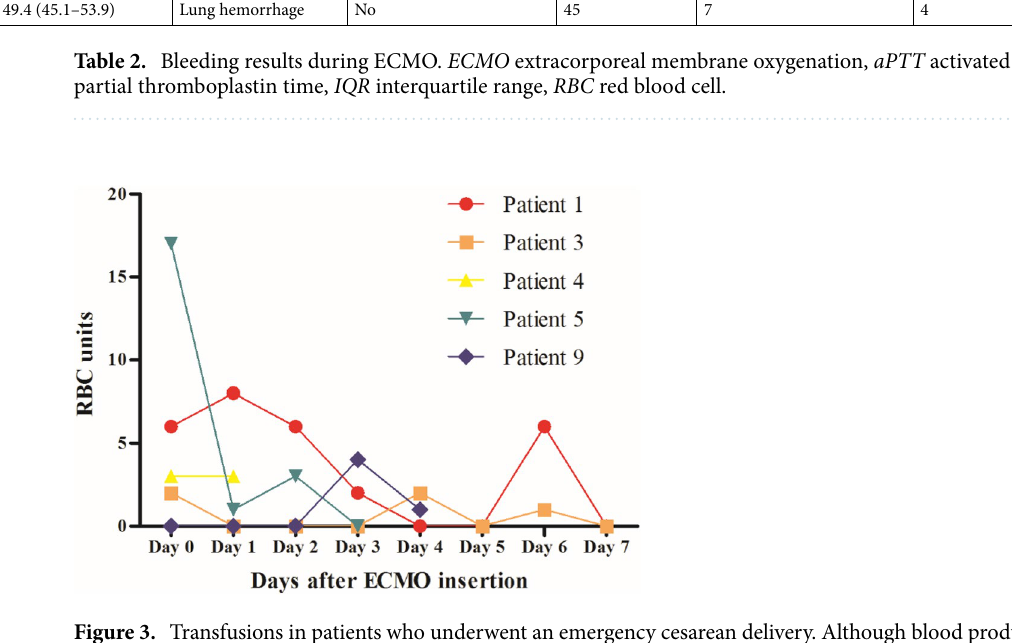
Figure 3. Transfusions in patients who underwent an emergency cesarean delivery. Although blood product requirement was high during early period of extracorporeal membrane oxygenation, it was decreased afterwards. RBC red blood cell, ECMO extracorporeal membrane